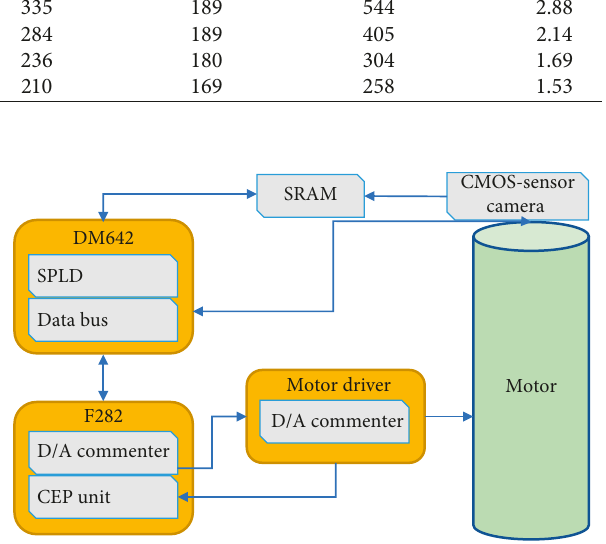
Figure 3: Schematic diagram of system